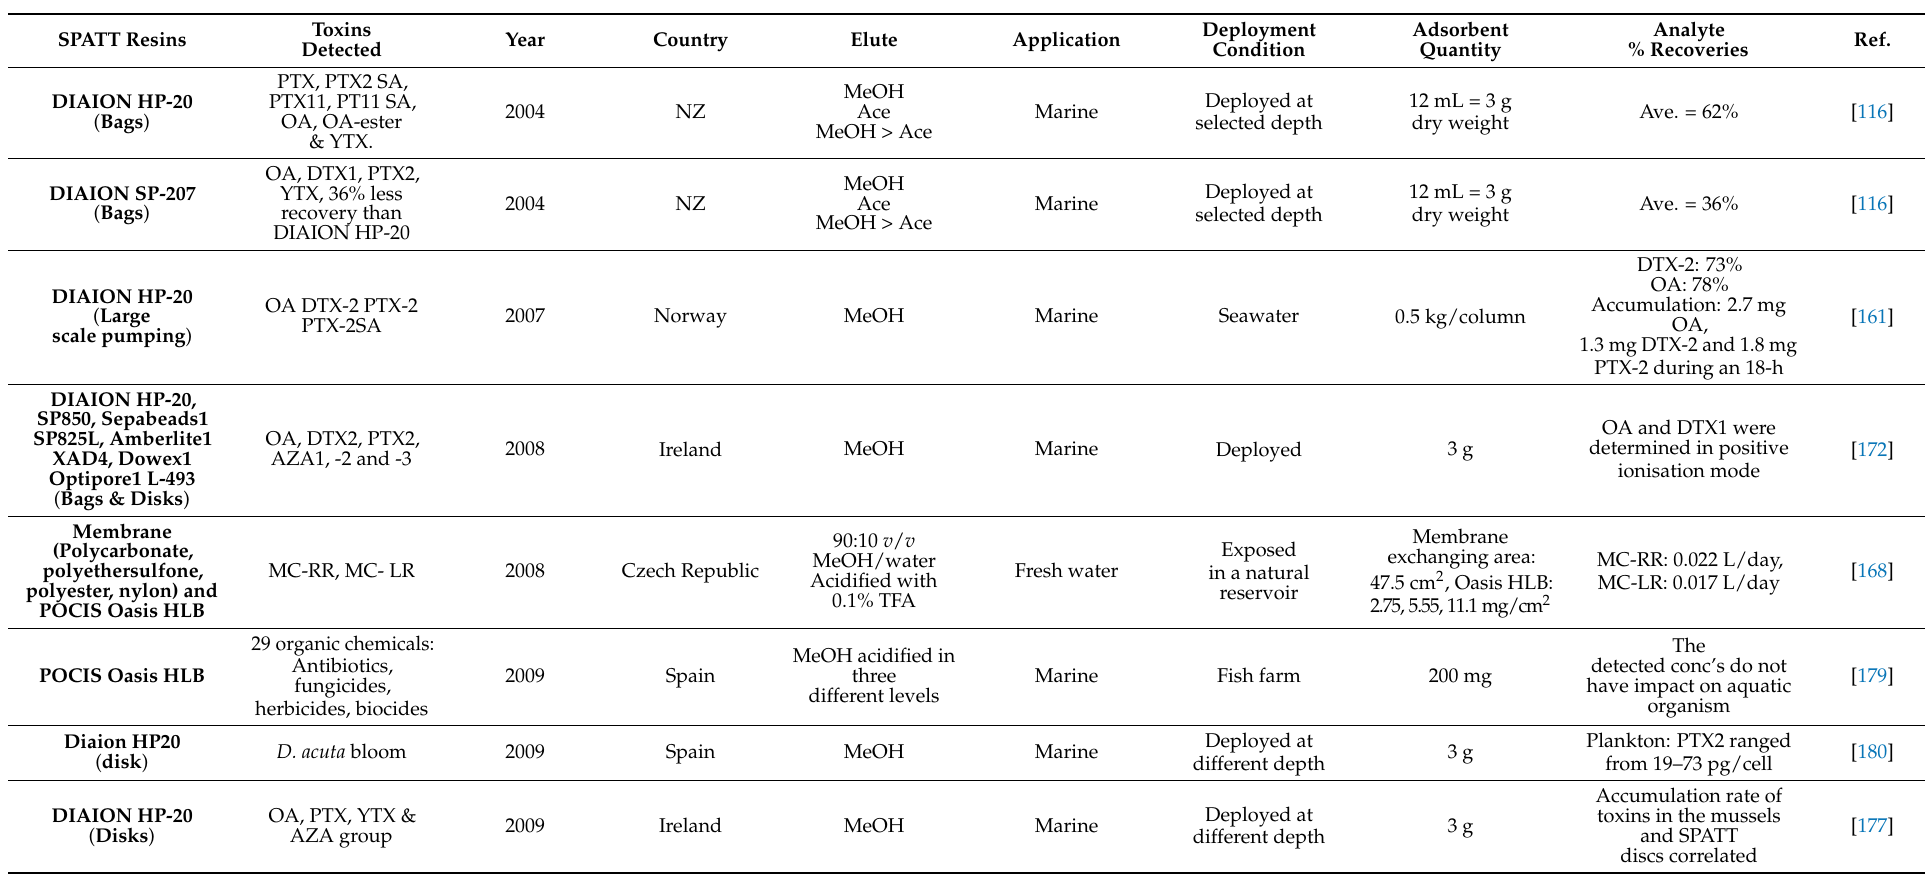
Table 5. Marine and Freshwater